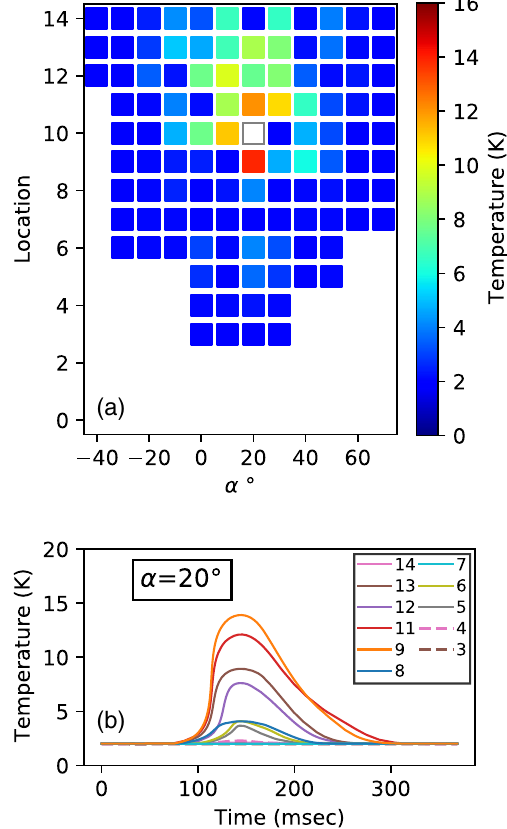
FIG. 6. Temperature rises during repeated quenching at 2 K, as indicated by “ canceled < 0 . 5 μ T ” in Fig. 4. (a) shows temper- ature mapping results of the spatial spreading of heating by quenches. (b) shows the time-series measurement of the heating observed at the sensors at the 20° board. (a) and (b) temperature mapping data were measured during regularly repeated quench events so-called self-pulsing quenching. Notably, these temper- ature mapping results were not